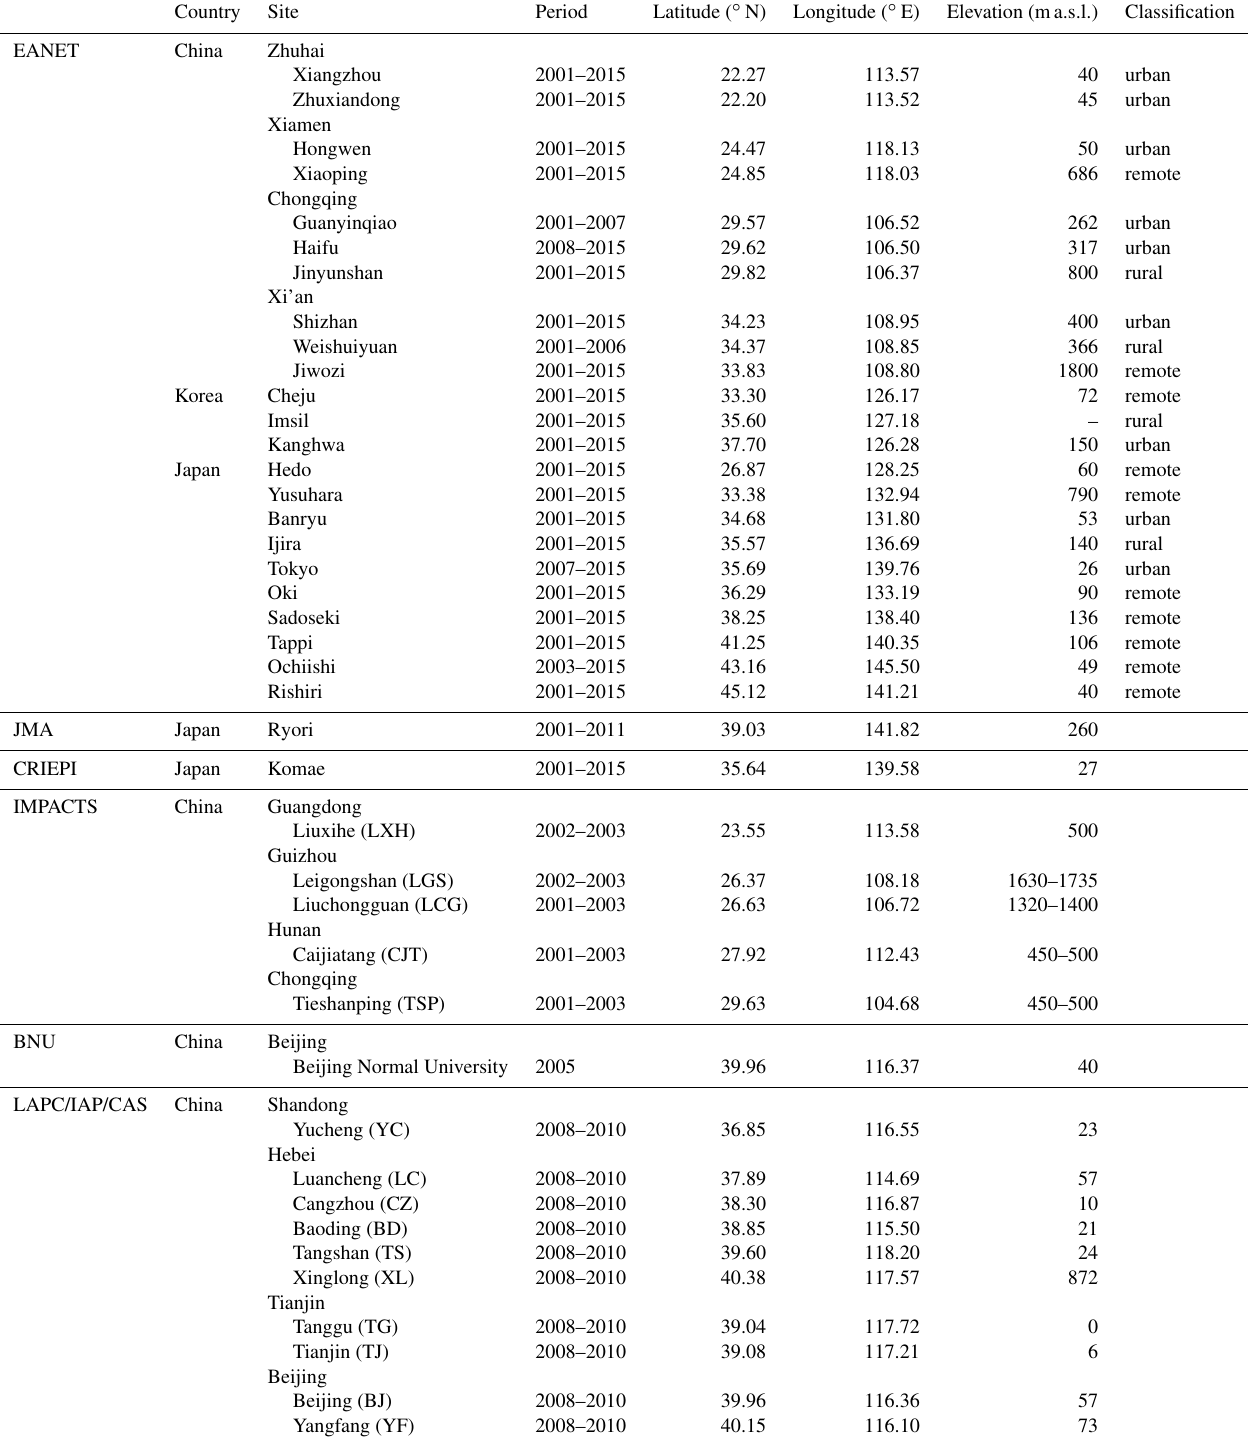
Table 1. Locations of observation sites included in this